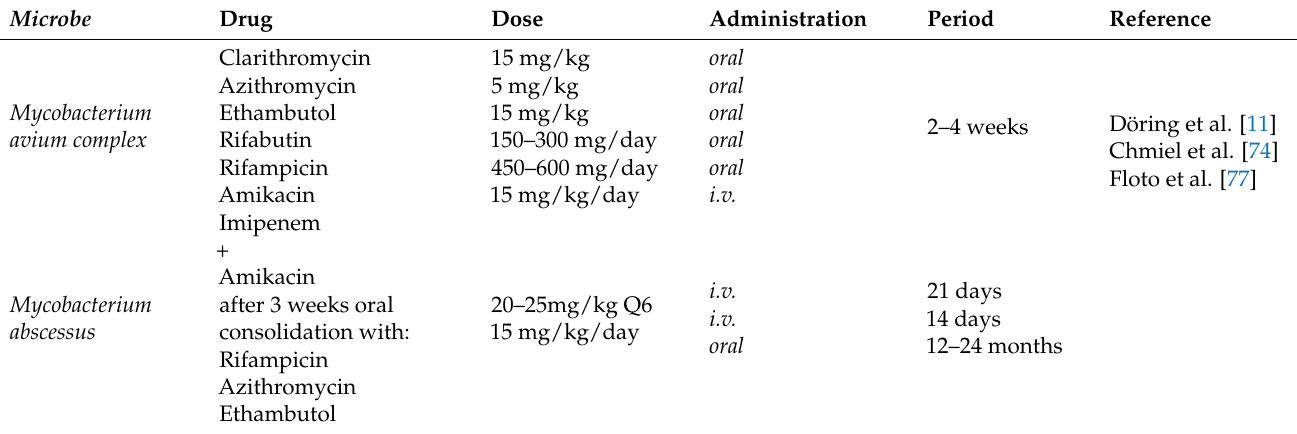
Table 6. Recommended antibiotics for Nontuberculous mycobacteria infection in CF